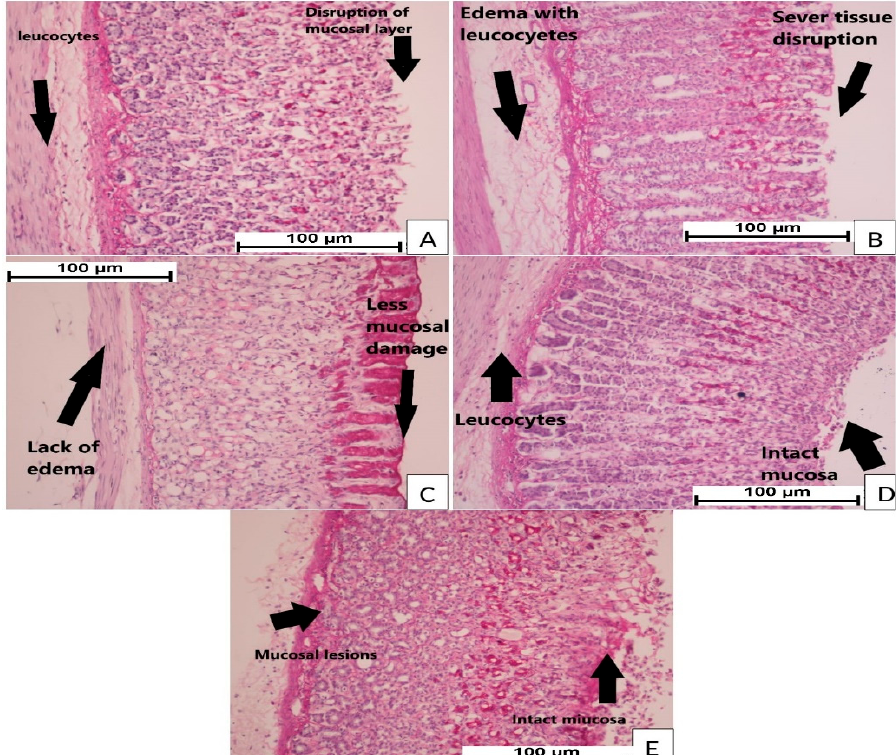
Figure 5. Influences of the PDE on the microscopic views of the gastric mucosa stained with PAS glycoprotein in the ethanol-induced ulcerogenic rats. ( A ), normal control had a normal appearance of the stomach mucosa; ( B ), ulcer control showed sever stomach tissue damage with mild magenta PAS stain; ( C ), reference rats (omeprazole, 20 mg/kg) had non-significant stomach tissue disturbances with a high PAS staining concentration; ( D ), rats received 200 mg/kg of the PDE had mild to moderate stomach tissue damage with fewer leukocytes in the submucosal areas; ( E ), rats received 400 mg/kg of the PDE showed mild gastric mucosal injury with fewer lesions and moderate expressions of the PAS stain (PAS stain magnification 20×).